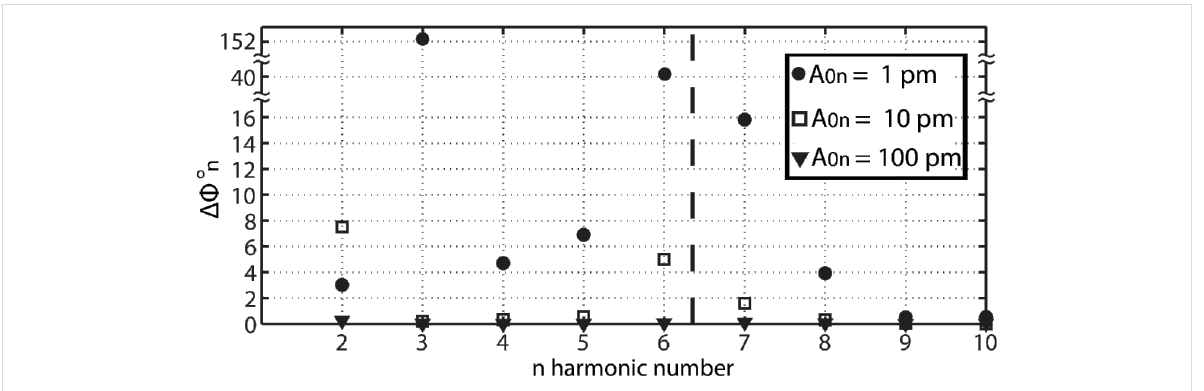
Figure 2: Phase shift analysis, in which the contrast in the higher harmonic phase shifts Δ = abs( ( H 2 ) − ( H 1 )), n = 2–10, which is induced by variations in the Hamaker constant H is shown. The variation in H is H 2 − H 1 = 1.0 × 10 − 19 J, where H 2 = 1.2 × 10 − 19 J, and effectively corresponds to variations in chemistry only. Results are shown when higher harmonic amplitudes A 0 n of 1 (circles), 10 (squares) and 100 (triangles) pm are intro- duced. Peak forces are smaller than 200 pN throughout.